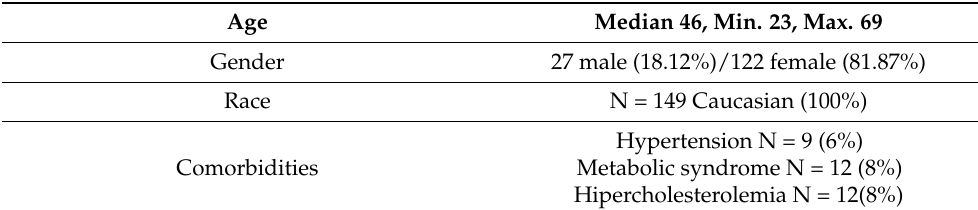
Table 2. General characteristics of the study